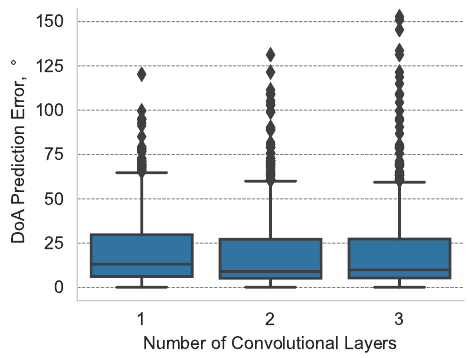
Figure 6. Angular errors of source DoA estimation at different number of CNN convolutional layers; Q = 10°, σ =